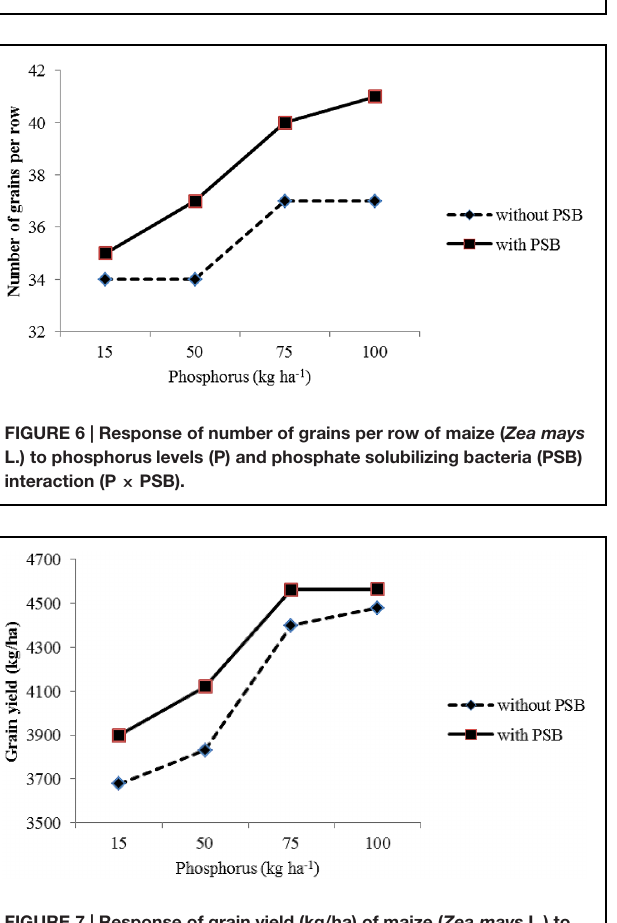
FIGURE 4 | Response of number of 1000 grains weight (g) of maize ( Zea mays L.) to compost application time (C) and phosphate solubilizing bacteria (PSB) interaction (C × PSB).